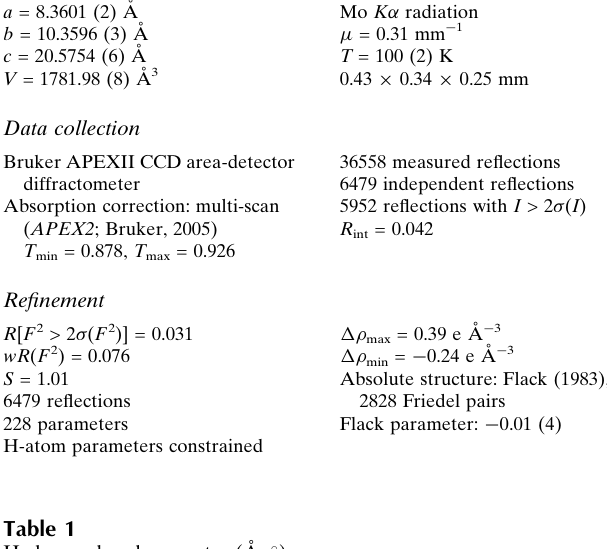
Hydrogen-bond geometry (A˚ , (cid:4)